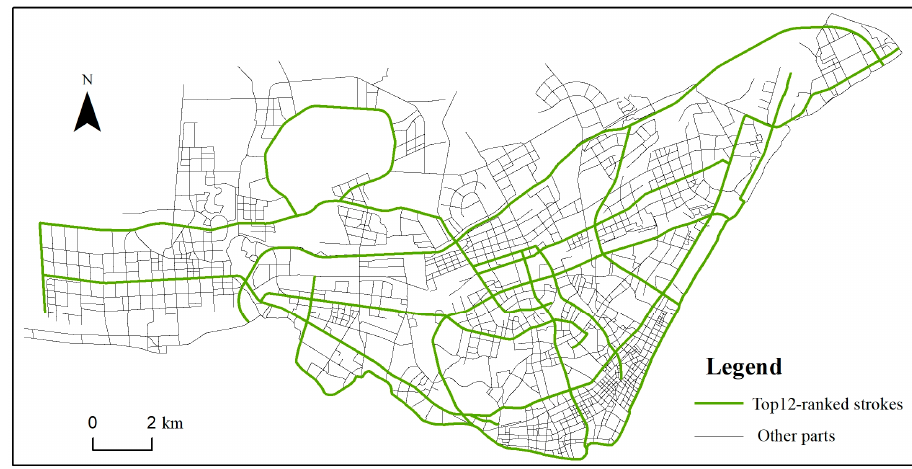
Figure 10. Twelve strokes with the highest BC values in the original road network. Table 6. Changes in the order of the top twelve-ranked strokes.